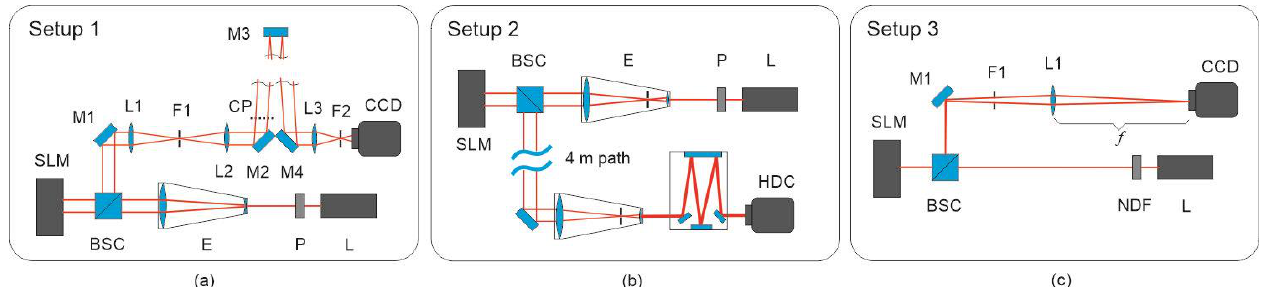
Figure 4. ( a ) Experimental setup. (Setup 1) (L) pigtailed 633 nm laser source, (P) linear polarizer, (E) beam expander, (BSC) beam-splitter cube, (SLM) reflection spatial light modulator, (M1, M2, M3 M4) mirrors, (L1, L2) 150 mm lenses, (F1, F2) filters, (CP) conjugate plane, (L3) 100 mm lens, (CCD) camera. This diagram exhibits the long path configuration. To achieve the shortest path, mirrors M2, M3 and M4 are removed. ( b ) (Setup 2) Experimental setup for long propagation. The difference from Setup 1 is the Keplerian beam expanders and the propagation over a 4 m path. The second expander collects the beam that passes through a series of mirrors to ensure a far field image. Finally, a full HD camera (HDC) is used to record the images. ( c ) (Setup 3) (L) HeNe laser source, (NDF) neutral density filter (BSC) beam-splitter cube, (SLM) reflection spatial-light modulator, (M1) mirror, (L1) 400 mm lens, (F1) filter, (CCD) camera.